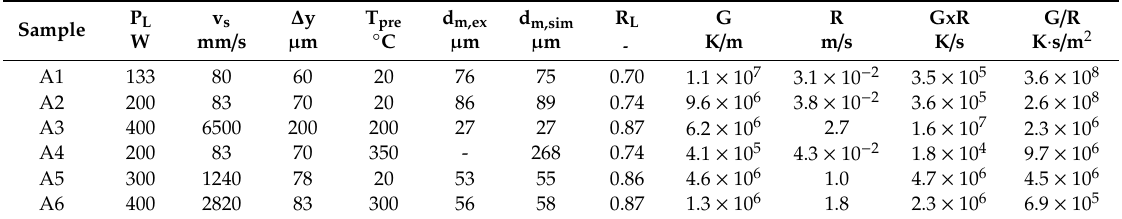
Table 5. Calculated solidification conditions of the specimens from Section